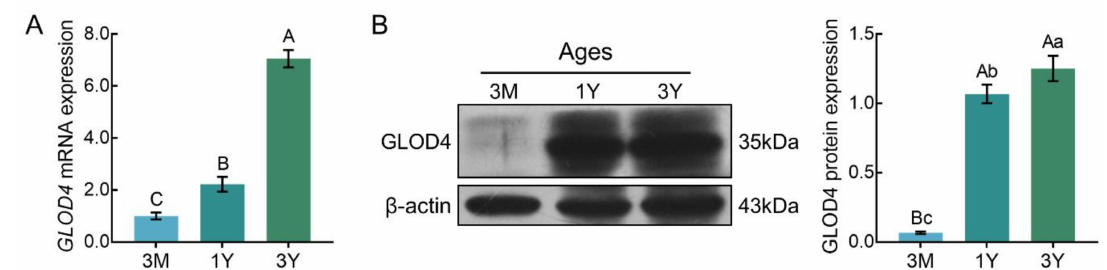
Figure 5. The relative expression levels of GLOD4 in sheep testes at di ff erent ages. ( A ) Relative GLOD4 mRNA expression. The bars represent the mean values ± SD from eight independent biological replicates with three technical replicates each. ( B ) Relative GLOD4 protein expression. β -actin was used as a reference gene. The bars represent the mean values ± SD from eight independent biological replicates with two technical replicates each. Di ff erent capital letters denote extremely significant di ff erences between groups ( p < 0.01), while di ff erent lower letters denote significant di ff erences between groups ( p < 0.05). 3M: 3 months old; 1Y: 1 year old; 3Y: 3 years old.